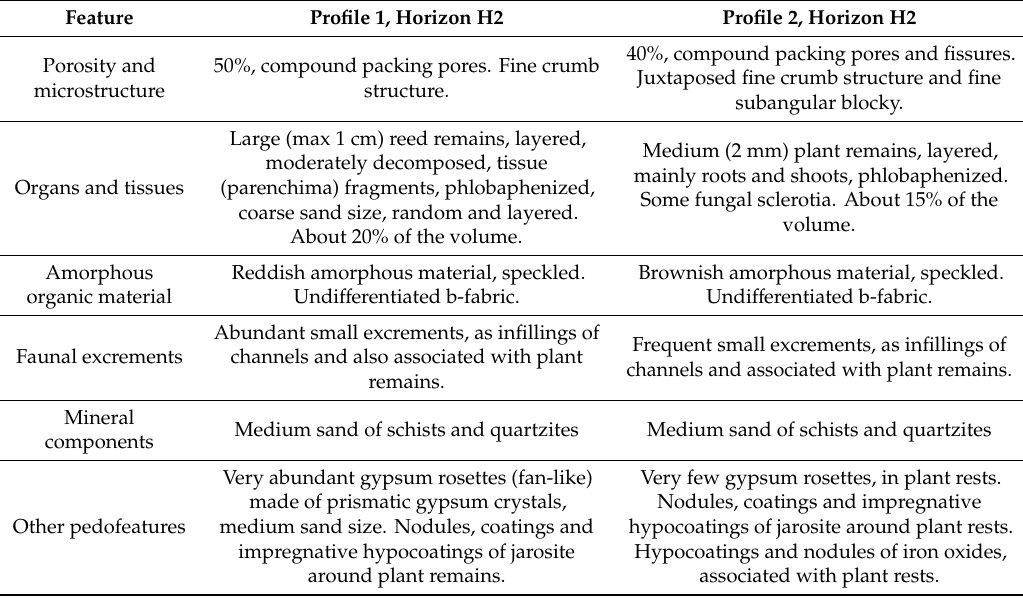
Table 3. Micromorphological description of organic horizons of profiles 1 and